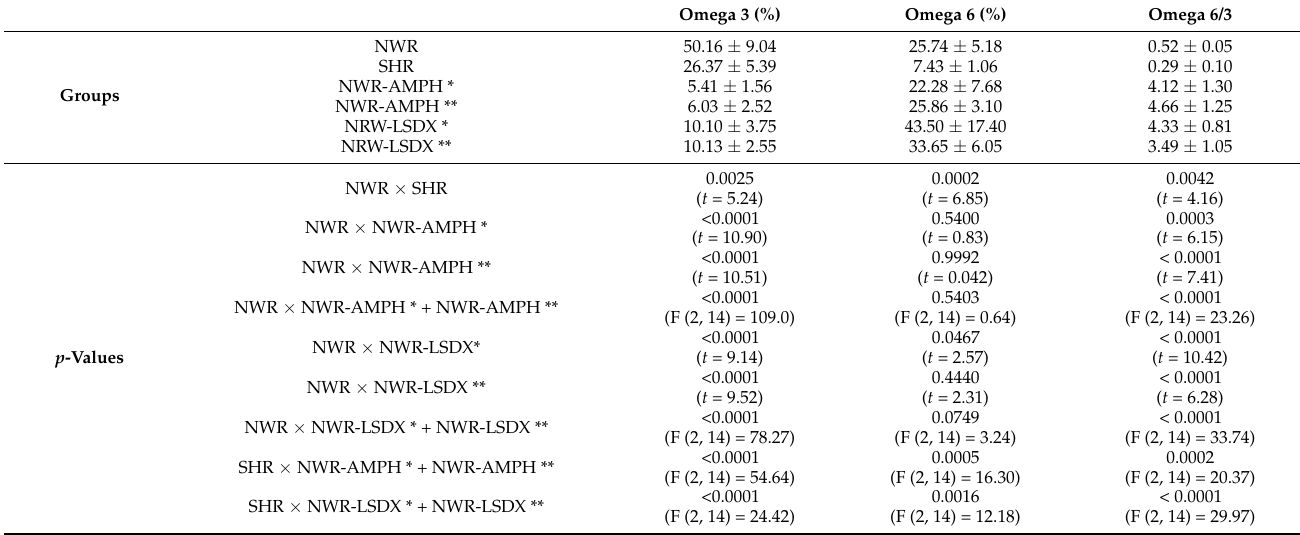
Table 2. Changes in omega-3 and omega-6 acids determination using the 1 H-NMR data from control NWR animals after the administration of psychostimulants (mean values ±